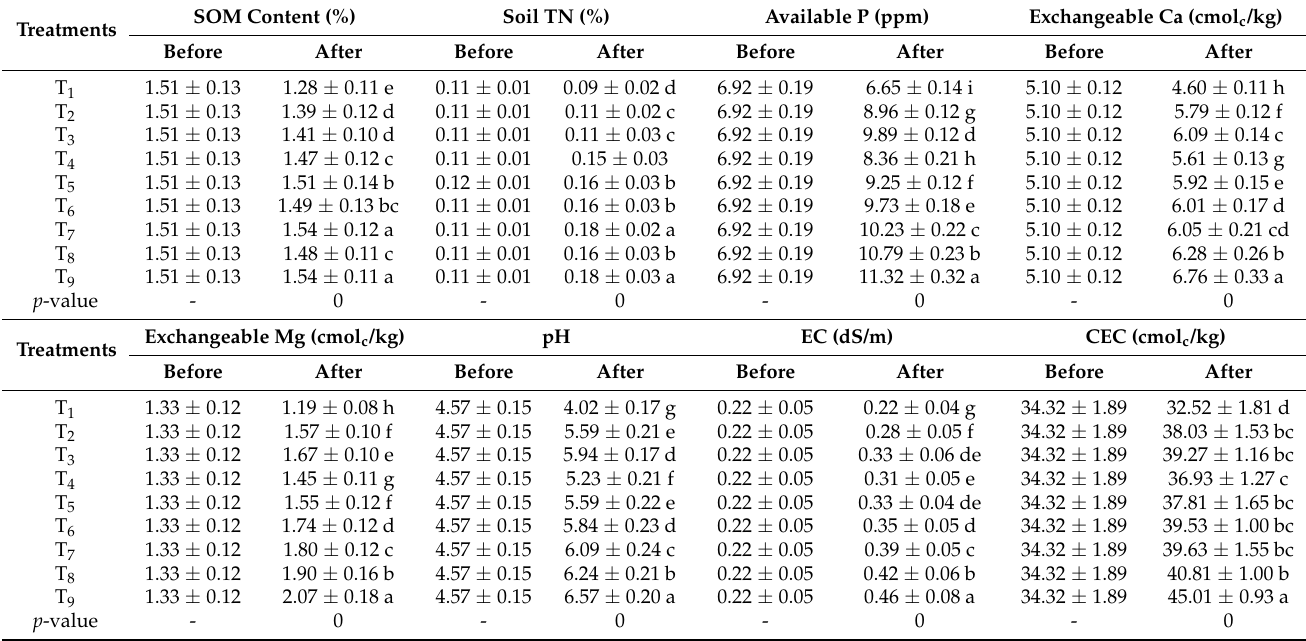
Table 5. Effect of lime and manure amendment on changes of soil properties under T. Aman–Mustard–Boro cropping pattern.